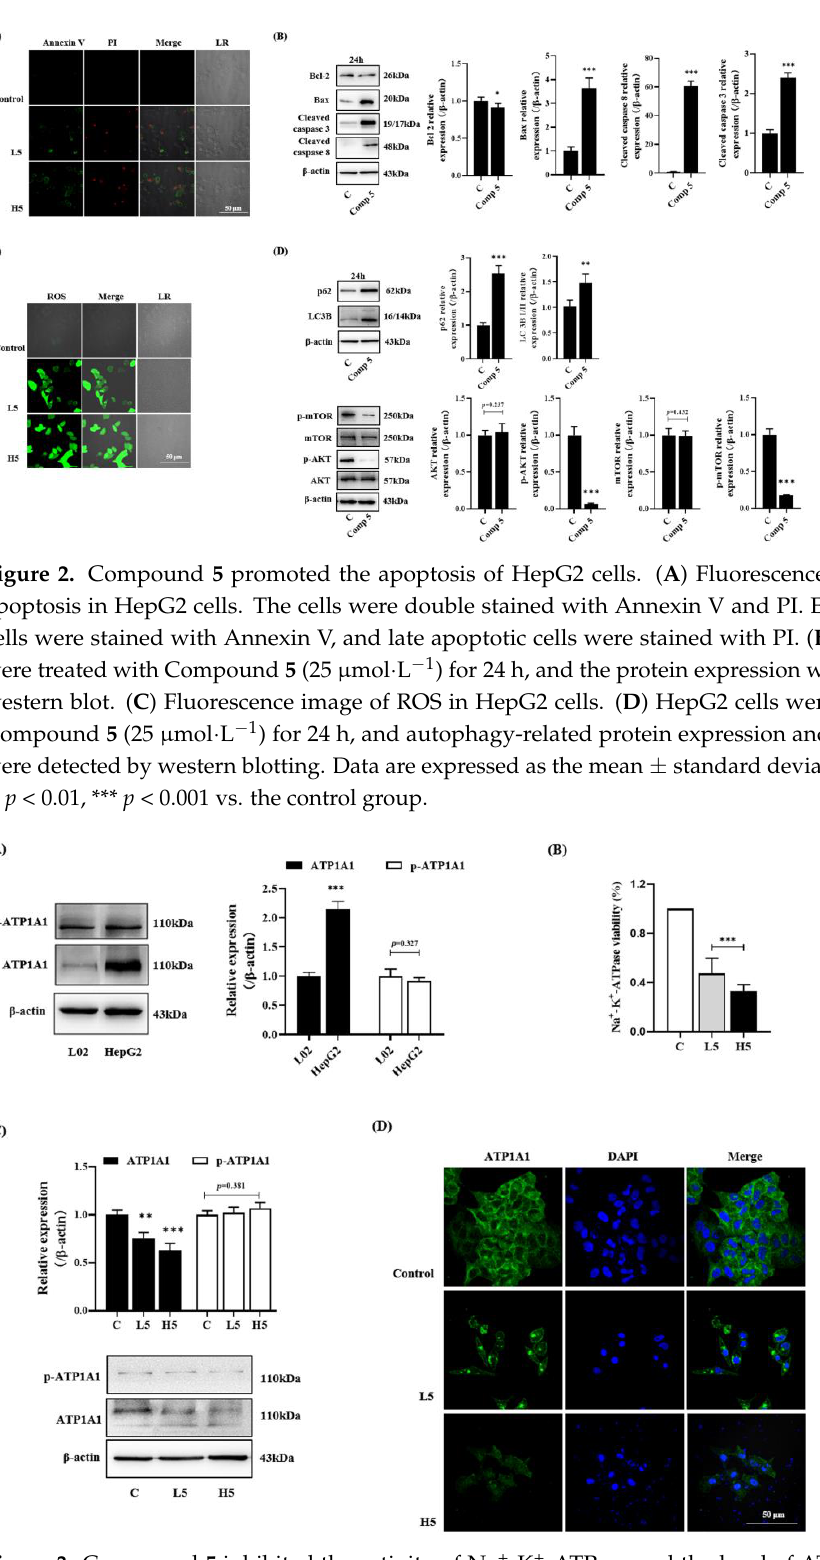
Figure 3. Compound 5 inhibited the activity of Na + -K + -ATPase and the level of ATP1A1 protein. ( A ) The expression and phosphorylation of ATP1A1 in L02 and HepG2 cells. ( B ) The effect of 5 on regulating the activity of Na + -K + -ATPase. ( C ) The effect of 5 on regulating the expression and phosphorylation of ATP1A1 in HepG2 cells. ( D ) Fluorescence image of ATP1A1 and DAPI in HepG2 cells. Data are expressed as the mean ± standard deviation. ** p < 0.01, *** p < 0.001 vs. the control